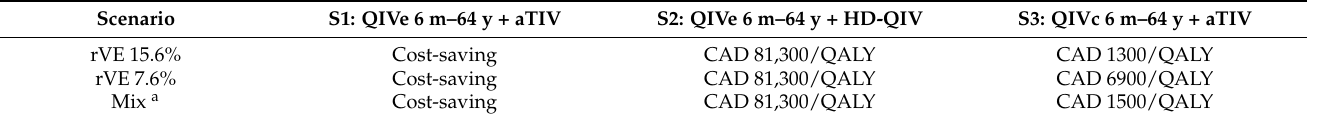
Table 4. Mean ICER estimates for each scenario across the relative vaccine effectiveness estimates.